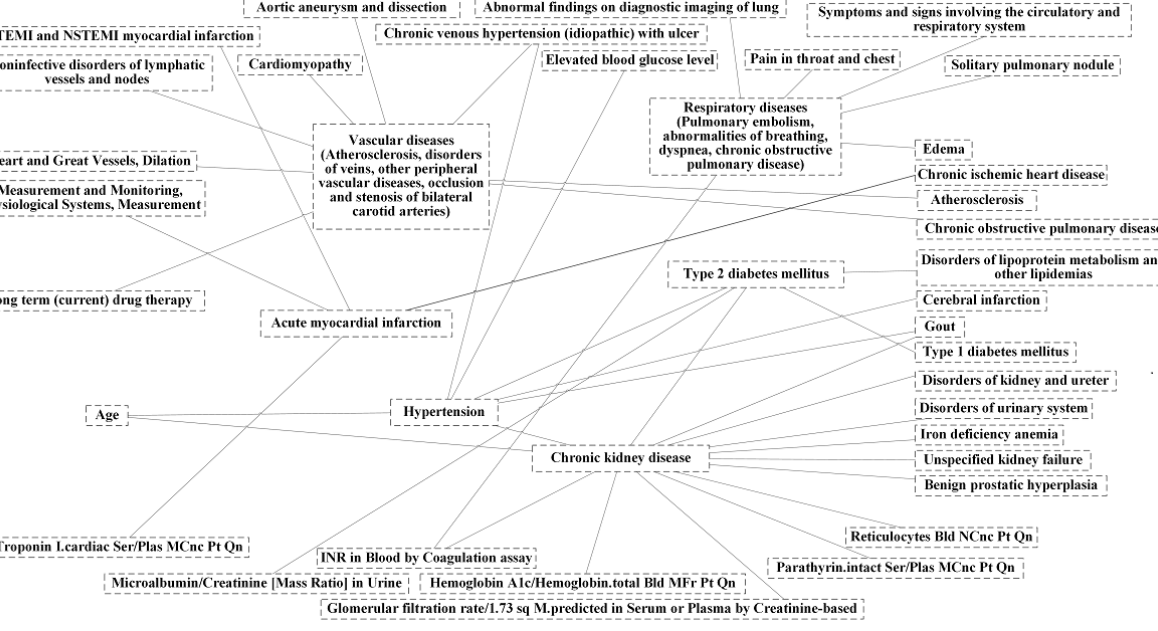
Figure 4. The important network structure of the predictive diagnostic features.